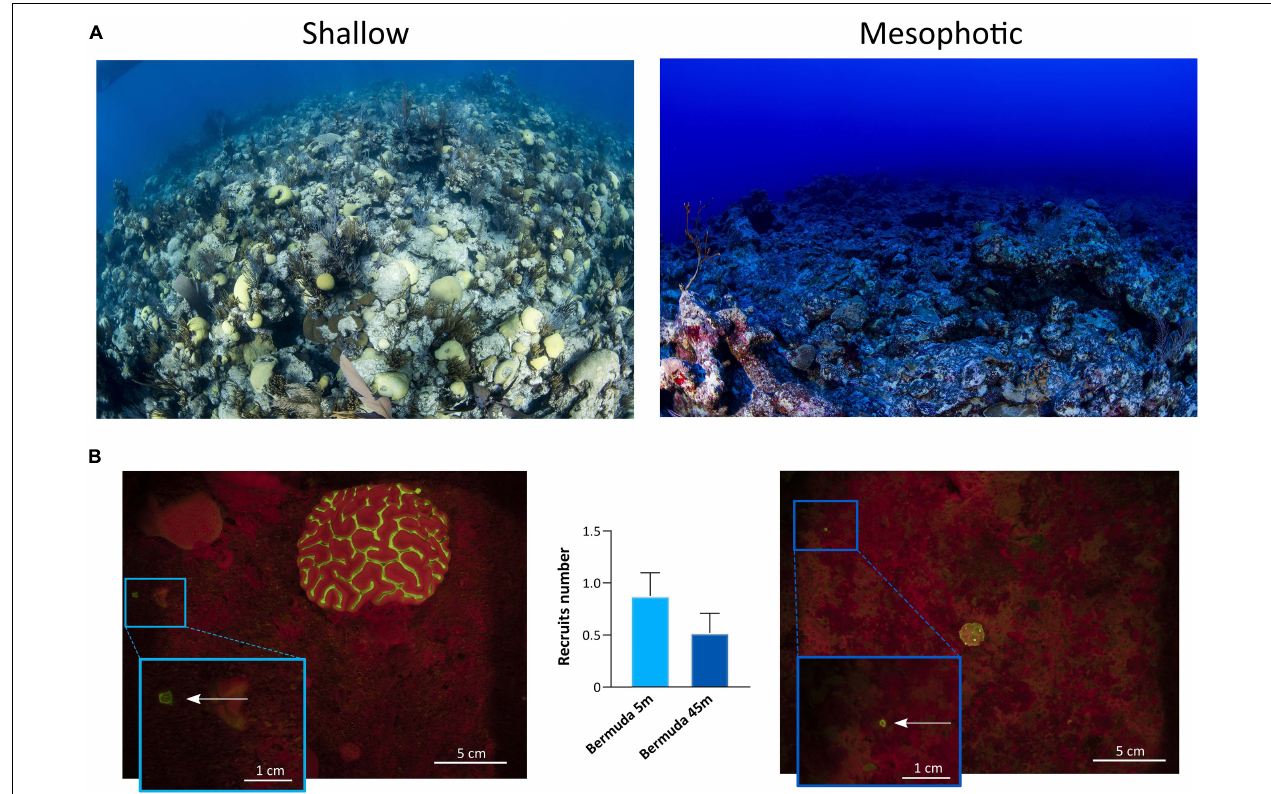
FIGURE 7 | Shallow and mesophotic reefs in Bermuda and detection of coral recruits. (A) Images of the sampling sites at the shallow (left) and mesophotic (right) reefs in Bermuda. (B) Fluorescence images of the quadrat deployed in the shallow (left) and mesophotic (right) reefs of Bermuda. The arrows within the insets point to coral recruits. The central graph shows the number of recruits identified in the shallow ( n = 17 quadrats) and mesophotic ( n = 21 quadrats) reefs of Bermuda. Values are shown as means ±